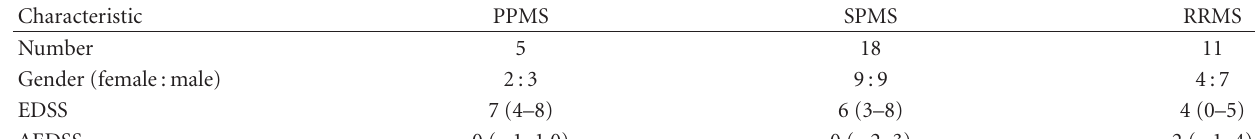
Table 2: Patient characteristics at 3-year followup. The median (range) are shown.